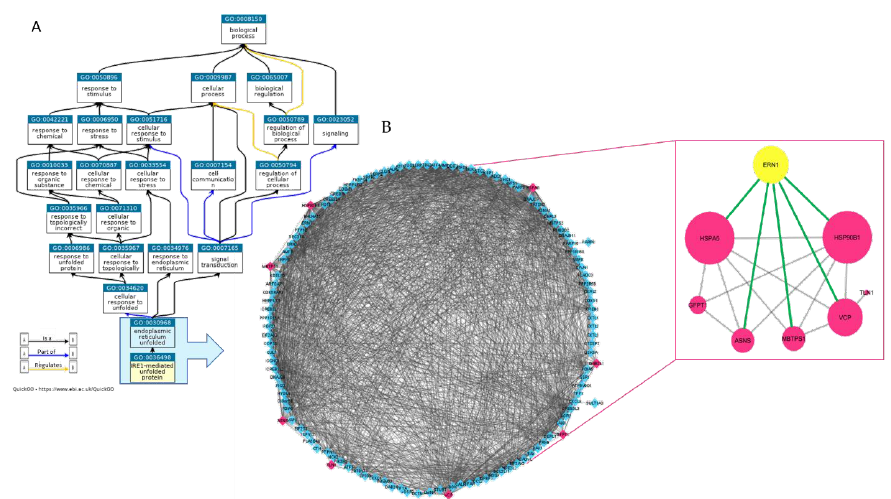
Figure 1. ( A ) Ancestor Chart within the domain “Biological Process” visualized by QuickGO. The turquoise box GO_terms on which we focused our attention. ( B ) STRING networks imported into Cytoscape. On the left the network formed by the 121 proteins included in GO:0030968 and GO:0036498 is reported; the eight proteins highlighted in fuchsia are those found in human multiple myeloma cell line (MM1.s)-extracellular vesicles (EVs). The network on the right shows that these eight MM1.s-EV proteins are reciprocally interconnected and five of them are directly connected to ERN1 (the inositol-requiring enzyme-1 alpha (IRE1α)). The node size indicates the number of connections of each node.